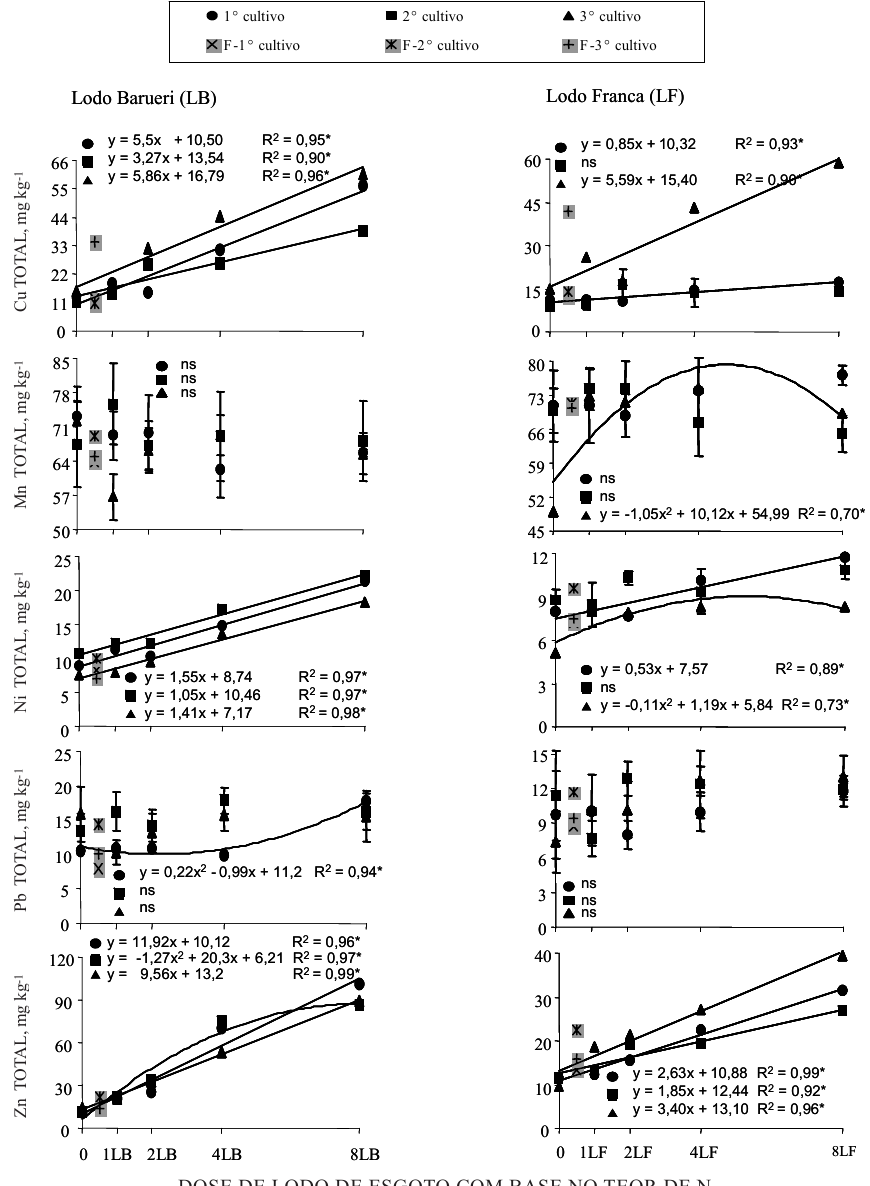
Figura 3. Teores totais de Cu, Mn, Ni, Pb e Zn em Latossolo sucessivamente tratado com lodos de esgoto e cultivado com milho. (* Modelo ajustado significativo a p ≤≤≤≤≤ 0,05 pelo teste F; ns = não-significativo; F = adubação mineral com NPK recomendada para a cultura do